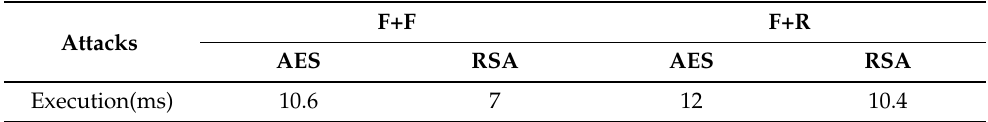
Table 7. Execution time of attack programs.